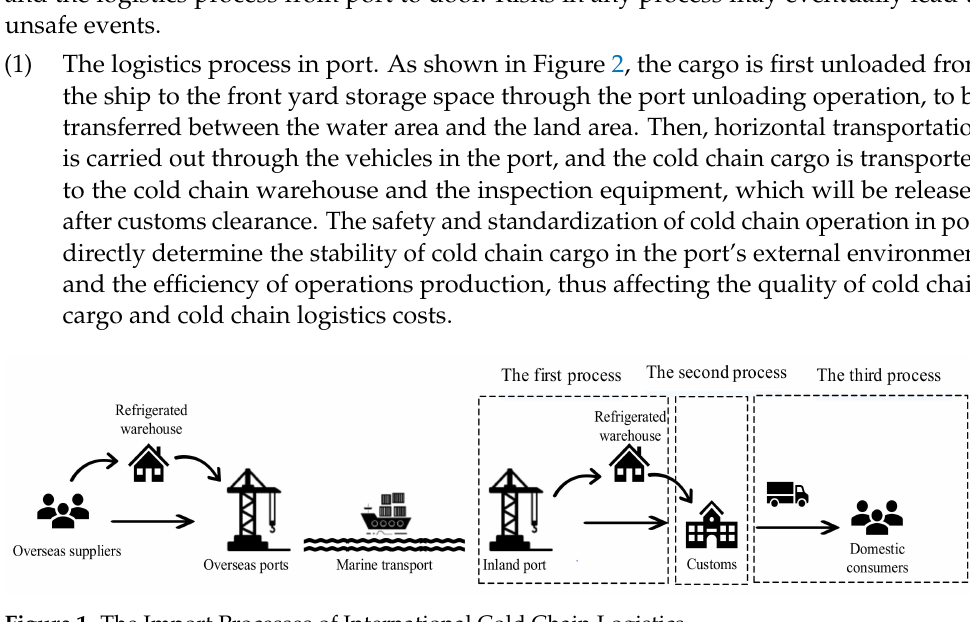
Figure 1. The Import Processes of International Cold Chain Logistics.